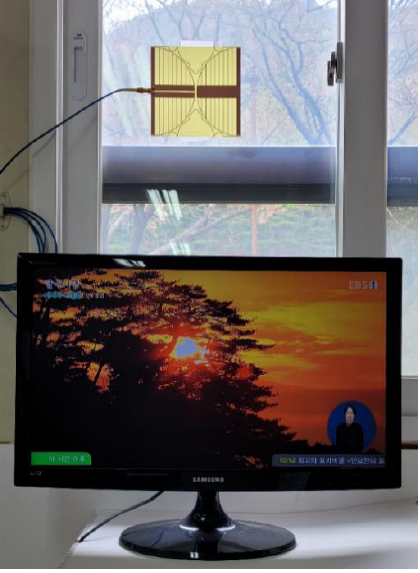
Figure 14. Fabricated antenna test for DTV reception inside a building when connected to a TV. Table 4 compares the size, impedance bandwidth, and gain of the proposed antenna with those of antennas in the literature, along with the antenna type. Table 4. Comparison among this work and other previously reported antennas in the literature.